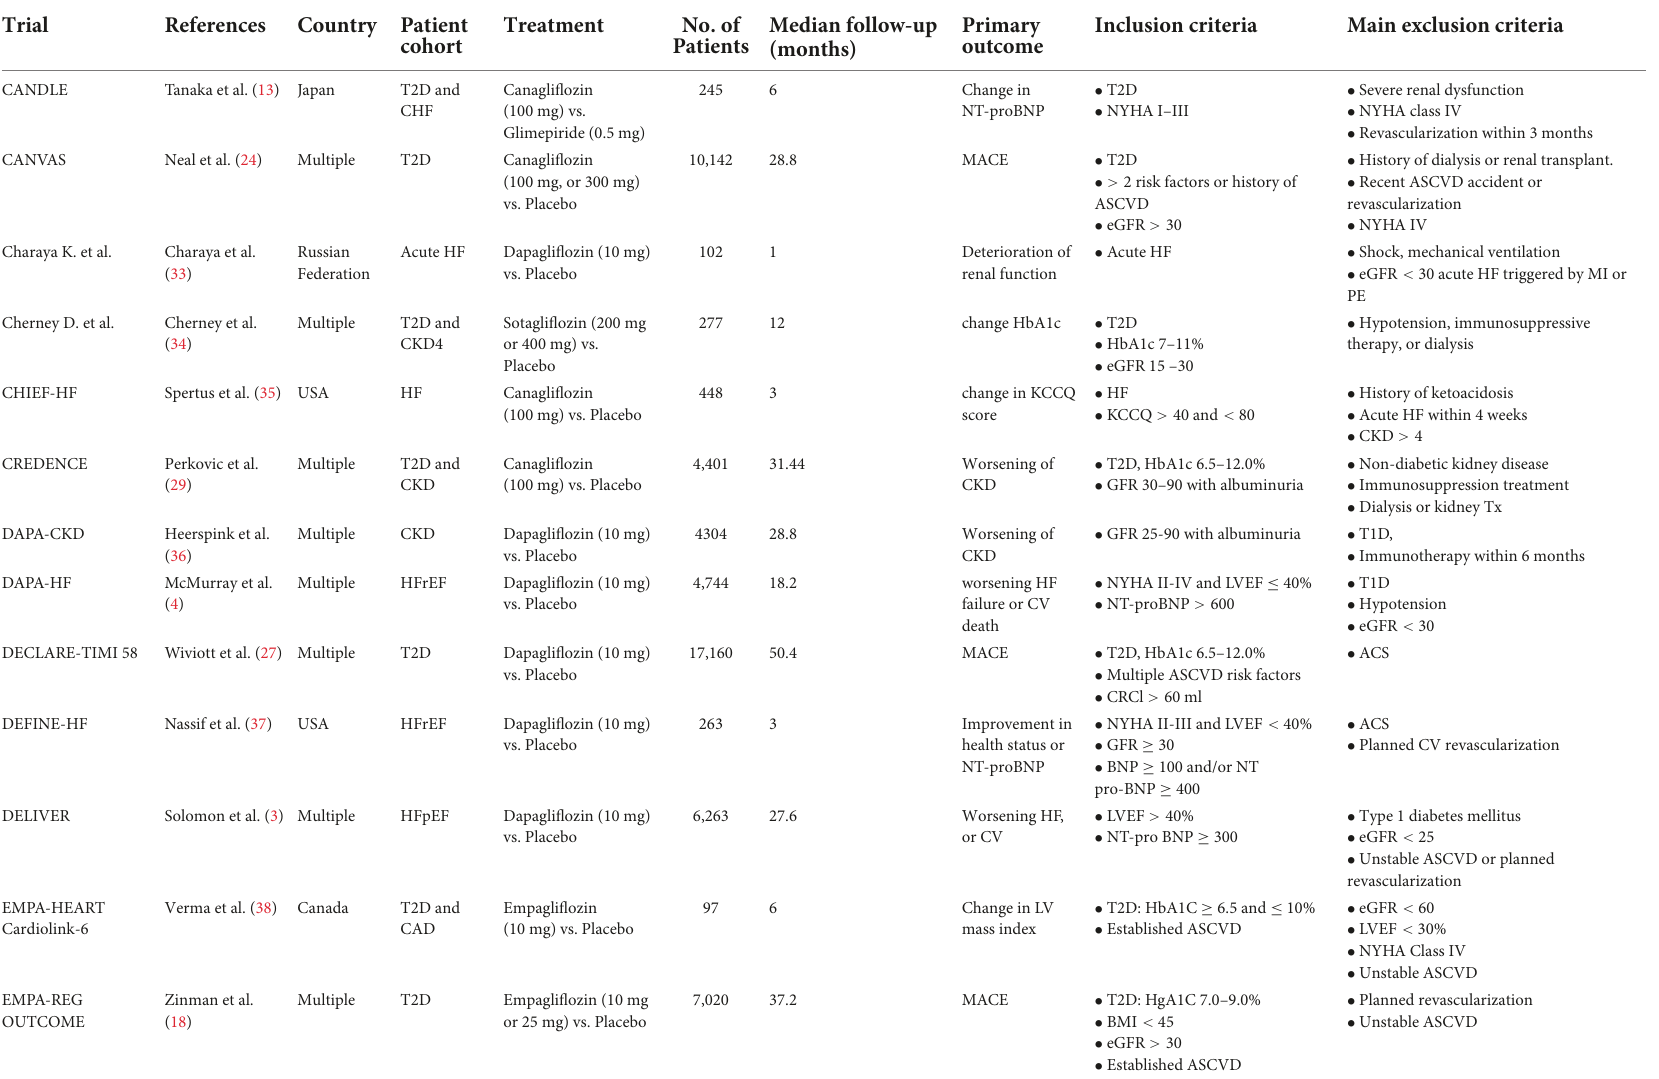
TABLE 1 Clinical characteristics of the included patient